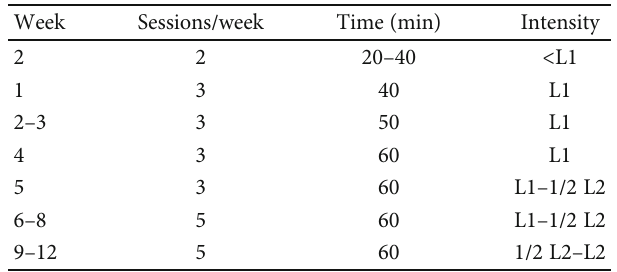
Table 1: Exercise